Question: Which kind of chart has been used to present this data?
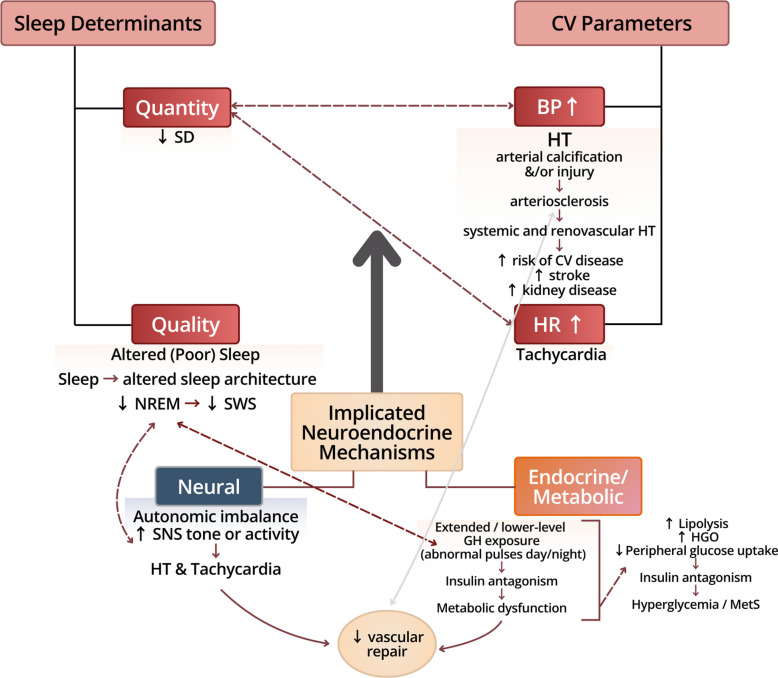
Answer: line